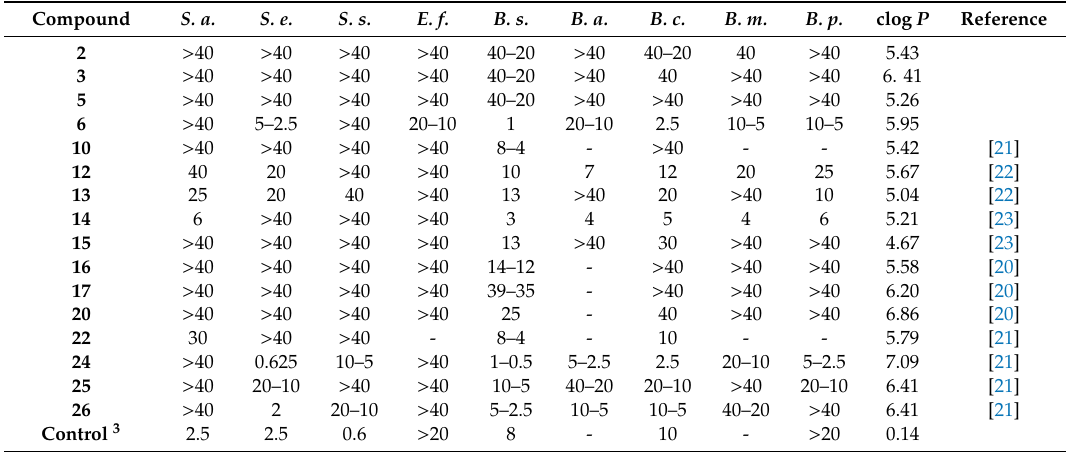
Table 1. Minimal inhibitory concentration (MIC, µ g / mL) 1 against Gram-positive bacteria of phenolic nor-triterpenes 2 and lipophilicity (clog P